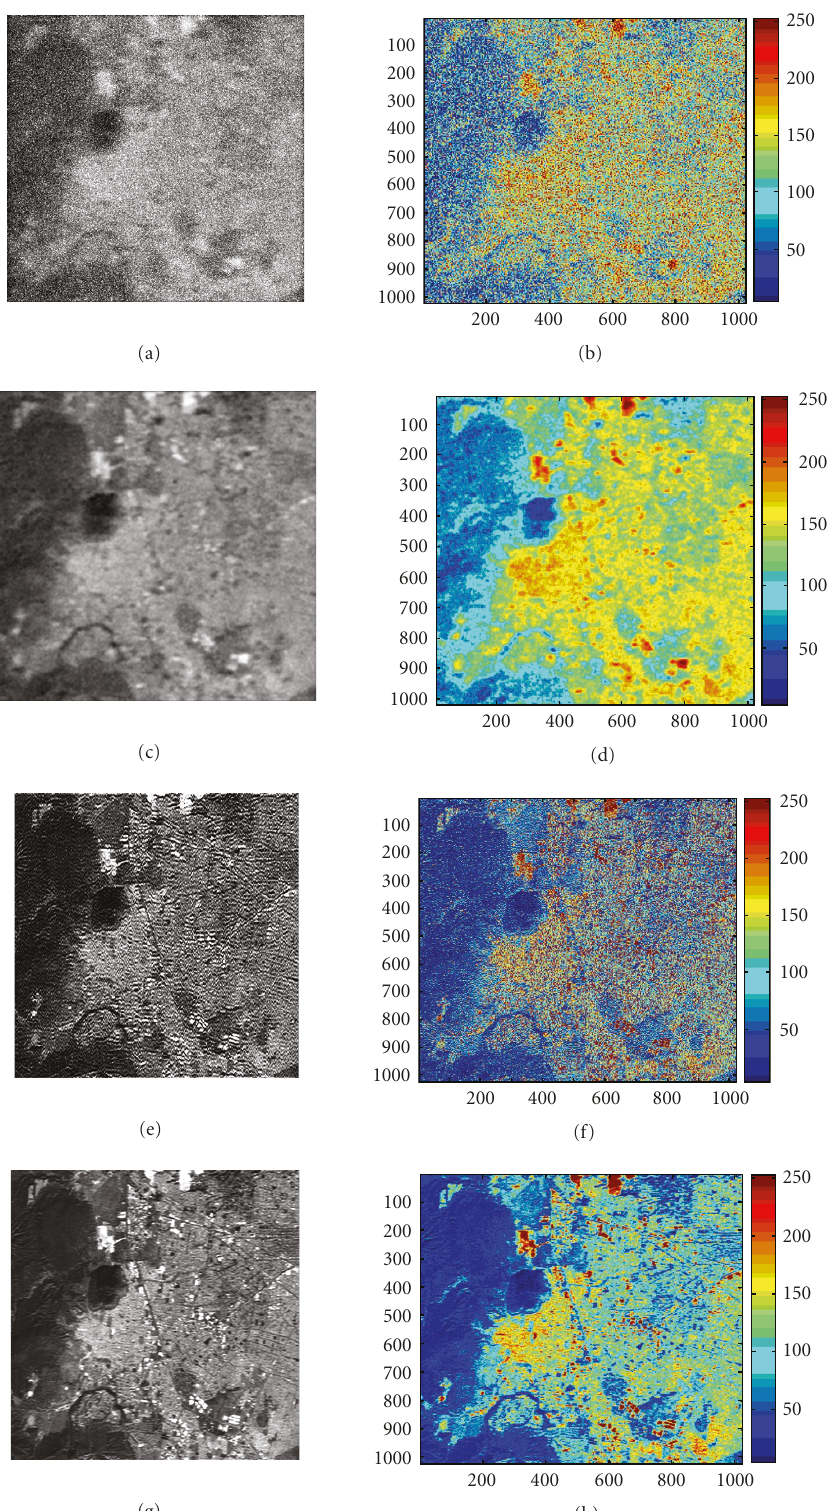
Figure 11: Simulation results for certain observation scenario: (SNR μ = 10dB): (a) degraded scene image formed applying the MSF method; (b) the same degraded scene represented in the MATLAB pseudo-color scale; (c) image reconstructed applying the Lee adaptive de-speckling algorithm; (d) the same adaptively de-speckled scene represented in the MATLAB pseudo-color scale; (e) image reconstructed applying the POCS-RSF algorithm; (f) image reconstructed applying the POCS-RSF algorithm represented in the MATLAB pseudo-color scale; (g) image reconstructed applying the POCS-RASF algorithm; (h) image reconstructed applying the POCS-RASF algorithm represented in the MATLAB pseudo-color